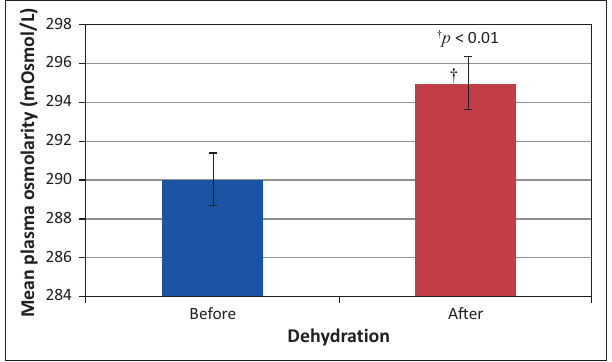
FIGURE 4: Mean plasma osmolality before and after dehydration in 50 participants. A paired t -test showed a significant increase ( p < 0.01) in mean plasma osmolality from the baseline value of 290.02 mOsmol/kg ± 1.25 mOsmol/kg to 294.96 mOsmol/kg ± 1.33 mOsmol/kg after dehydration.